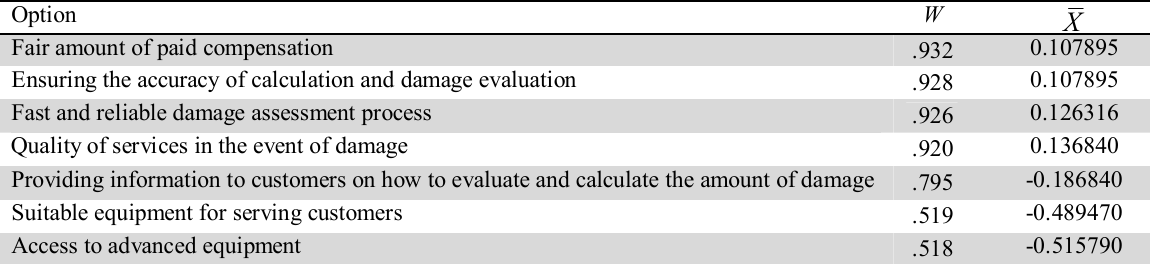
The summary of factors associated with quality of service casualties Option W X Fair amount of paid compensation .932